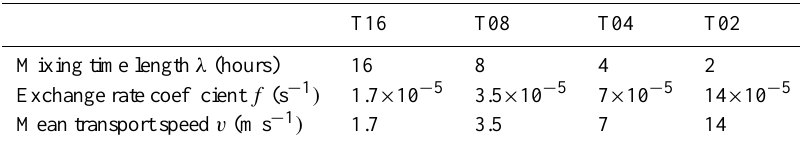
Table 3. The settings used for the sensitivity simulations. The equivalent mean transport speed is estimated based on the assumption of a characteristic spatial scale for Beijing of 100km.